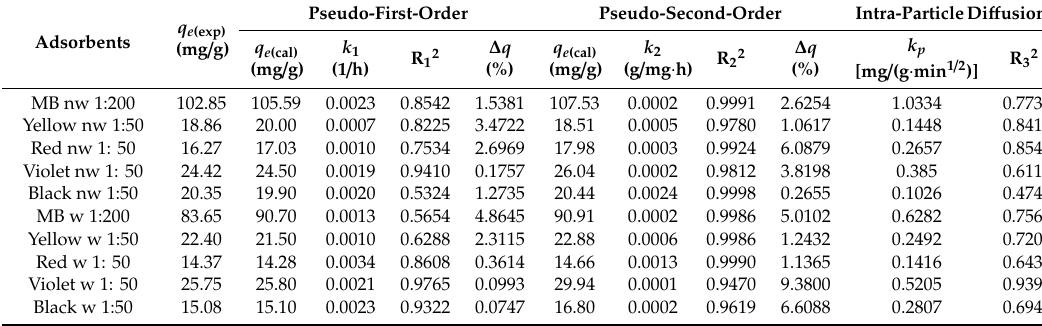
Table 1. Kinetic parameters of di ff erent models for various dyes adsorption on the not washed (NW) and washed (W) digestate adsorbent. MB, Methylene Blue.